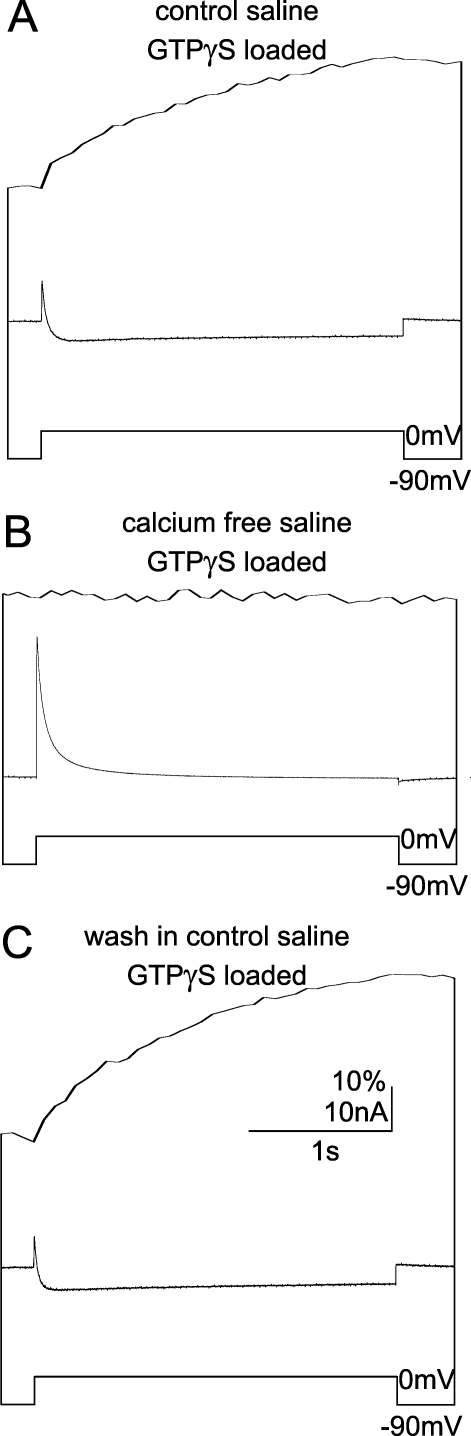
Voltage-Induced Intracellular Calcium Signals Depend on G-protein ActivationAcutely isolated neurons are loaded with GTPγS (100 μM), and a voltage step from −90 mV to 0 mV is repeated 30 times in calcium-containing saline to minimize availability of native G-protein.(A) In calcium-containing saline depolarization causes calcium inward current accompanied by an intracellular calcium signal.(B) Exposing the GTPγS-loaded cell for 3 min to zero-calcium saline causes a complete loss of membrane currents and the calcium signal.(C) Switching back to calcium-containing saline for 3 min restores the original current and the calcium signal.